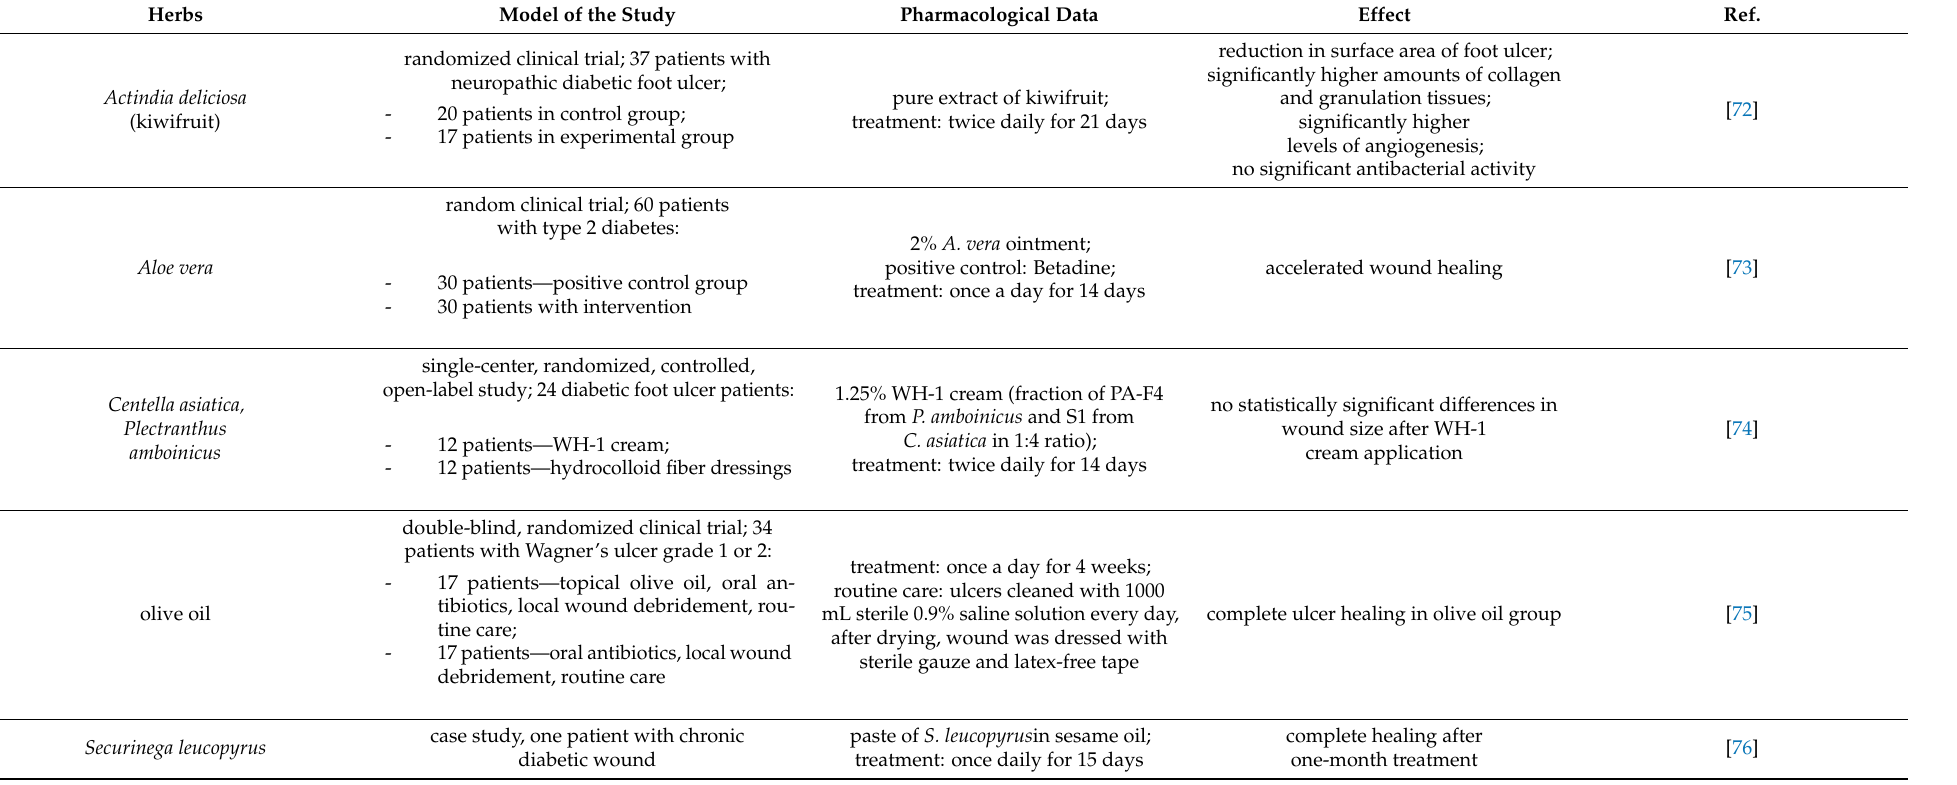
Table 4. Herbal products used for diabetic wound healing, human-based